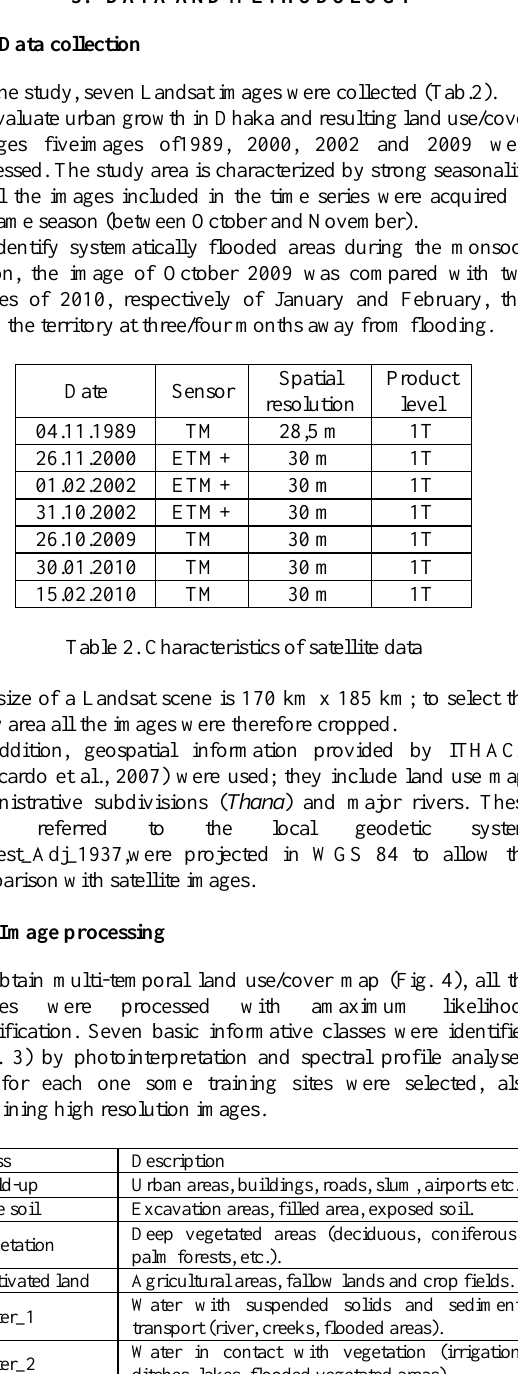
Figure 5. Examples of ground truth points in the Landsat images and in the high-resolution